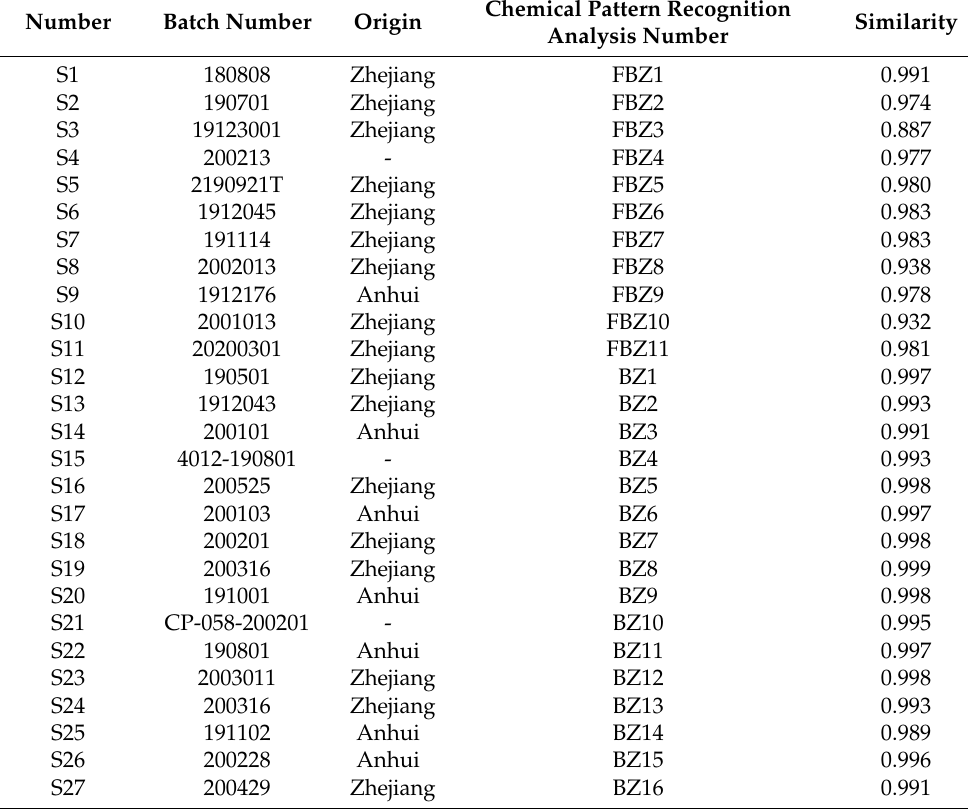
Table 2. The detailed information on AMR and the results of